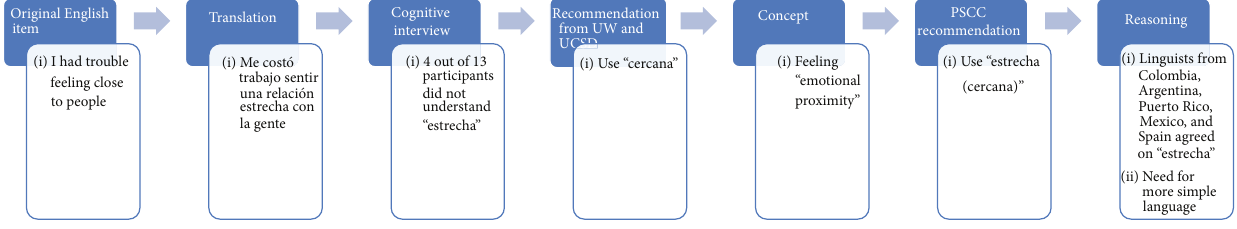
Figure 2: Example of the use of the flow diagram on one of the depression